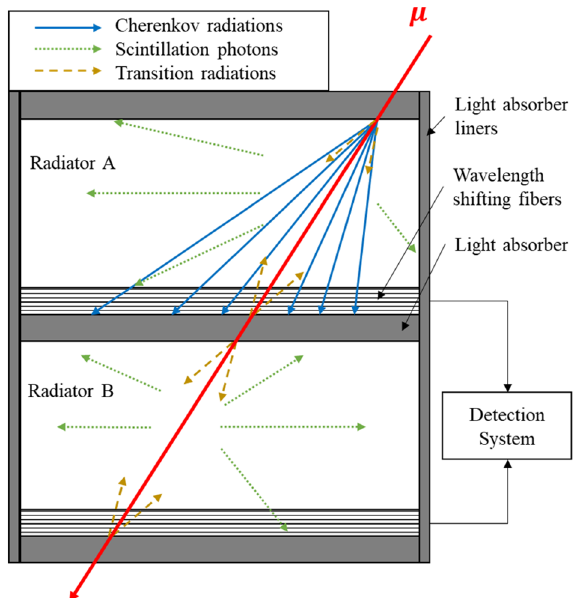
Figure 1. Characteristics of photon emission. Cherenkov radiation, scintillation, and transition radiation can be emitted in radiators. Radiator A (top) emits Cherenkov photons since p μ > p th whereas radiator B (bottom) does not because p μ < p th . However, both radiators emit scintillation and transition radiation regardless of the actual muon momentum. Due to the forward-biased directional photon emission of Cherenkov radiation, scintillation photon signals can be efficiently discriminated.